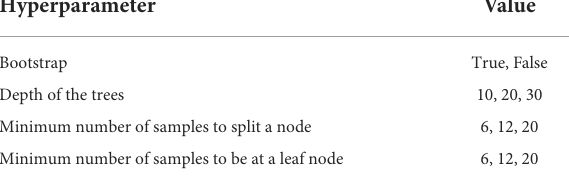
TABLE 3 Values of the hyperparameters contained in the grid